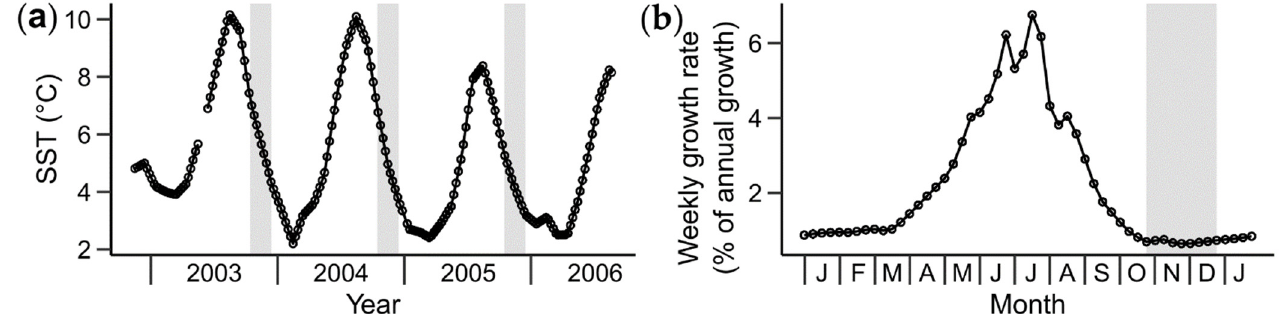
Figure 2. Water temperature and typical seasonal shell growth of Arctica islandica . ( a ) Weekly sea surface temperature data at Grímsey station [82] between December 2003 and August 2006. ( b ) Seasonal shell growth model (weekly resolution) of Arctica islandica in shallow waters based on [78]. Vertical gray bars denote annual growth lines.